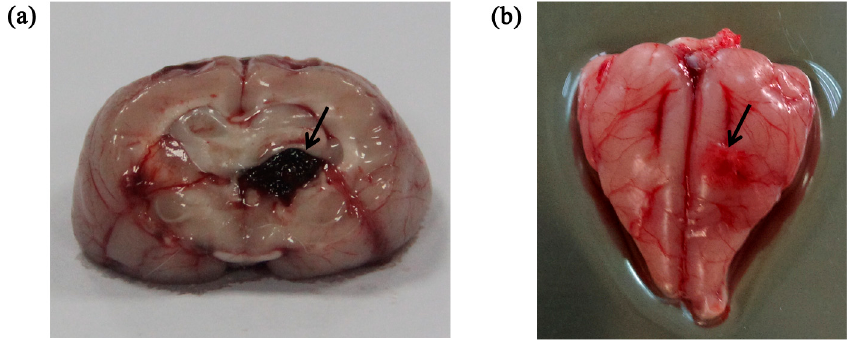
Figure 2. ( a ) Intracerebral hemorrhage model; ( b ) Ischemic model. The arrow indicates the location of the stroke lesion.